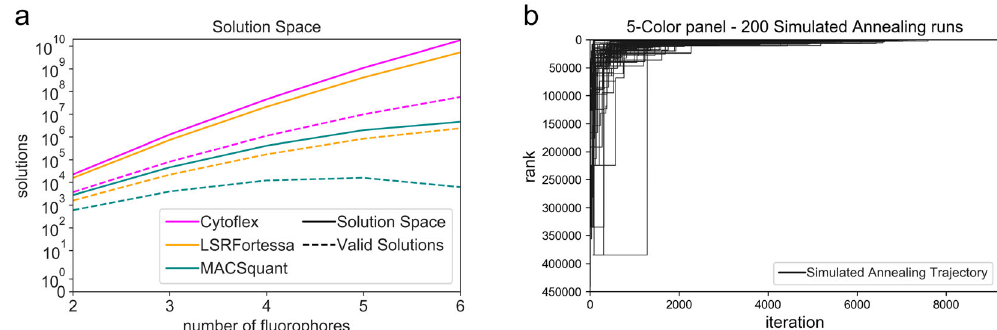
Fig. 2 Computational performance of fl uorophore selection algorithms. a The number of possible solutions and valid solutions for selecting fl uorophores from the library of 12 fl uorophores (used in the case study) on any given machine increases exponentially with the size of the panel. This shows that for larger panel designs, it is not feasible to exhaustively search the entire solution space, and an ef fi cient heuristic is required to fi nd an optimal panel. b Trajectories of 200 runs of simulated annealing to search for a 5-color panel from a library of 8 fl uorophores, for an instrument with 19 detectors. Each simulated annealing run has over 9000 iterations and the plot shows the rank of the best panel at any point of time during the run. The trajectories converge to the optimal solution (the best rank) toward the end of the run. This shows that the simulated annealing approach is a reliable heuristic to fi nd an optimal panel